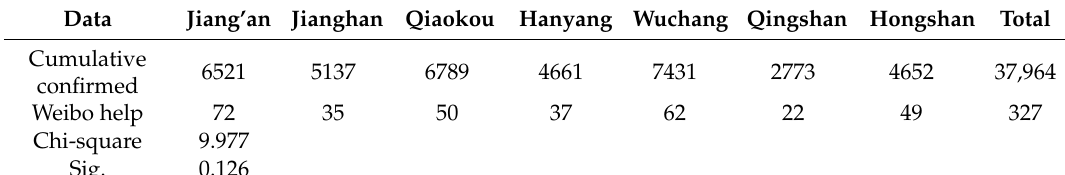
Table 1. Statistics of the Weibo data and the confirmed cases.